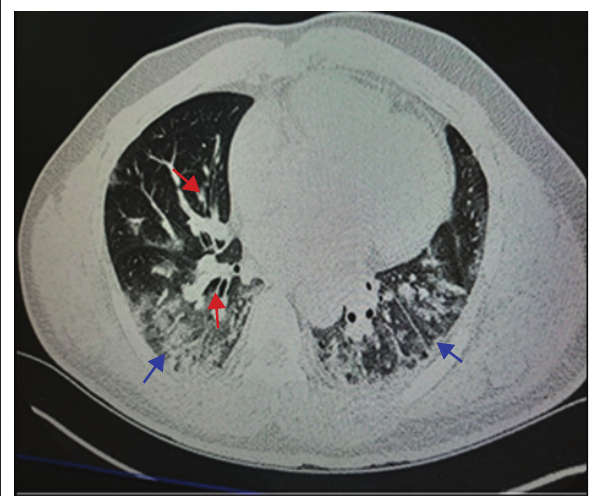
FIGURE 2: High resolution computerised tomography scan of a 60 year old female patient with COVID-19 (37 Military Hospital, Accra, Ghana, April 2020). Case 2: Axial image showing traction bronchiectasis in an area of ground-glass opacities (red arrows) and bilateral ‘crazy paving’ opacities (blue